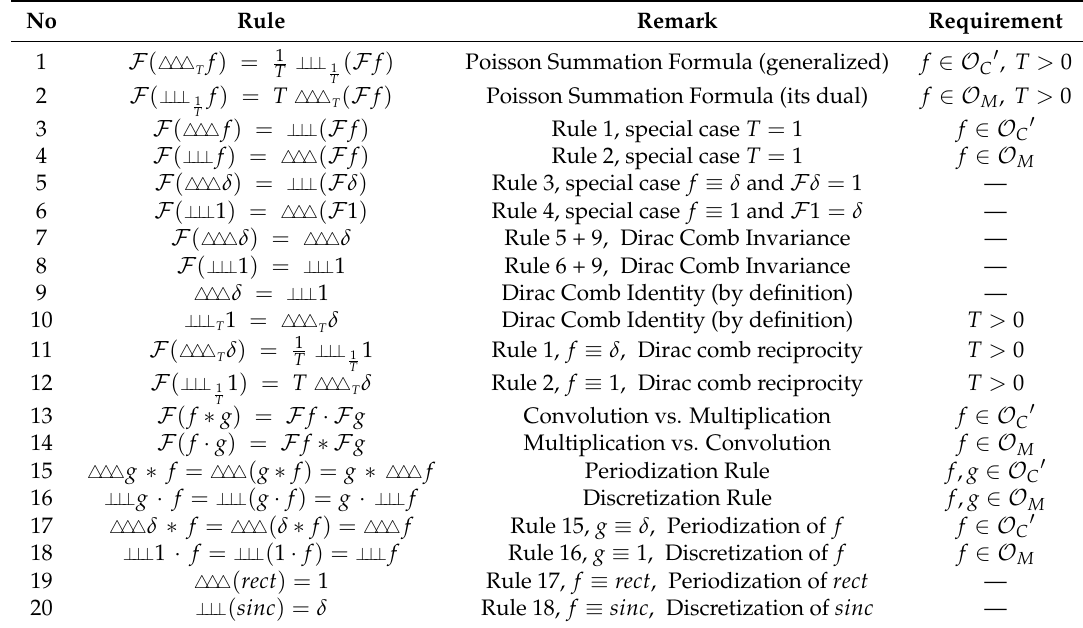
Table 1. Discrete Functions vs. Periodic